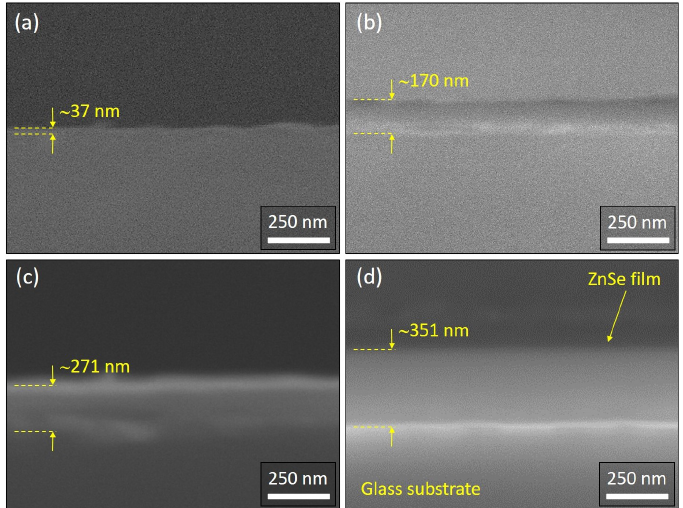
Figure 4. Cross-sectional SEM micrographs of the ZnSe thin films sputtered on glass substrates for 30 min, while keeping a constant gas pressure of 0.86 Pa and applying an RF power of: 60 W ( a ), 80 W ( b ), 100 W ( c ) and 120 W ( d ). Corresponding SEM measurements of the ZnSe films thickness are